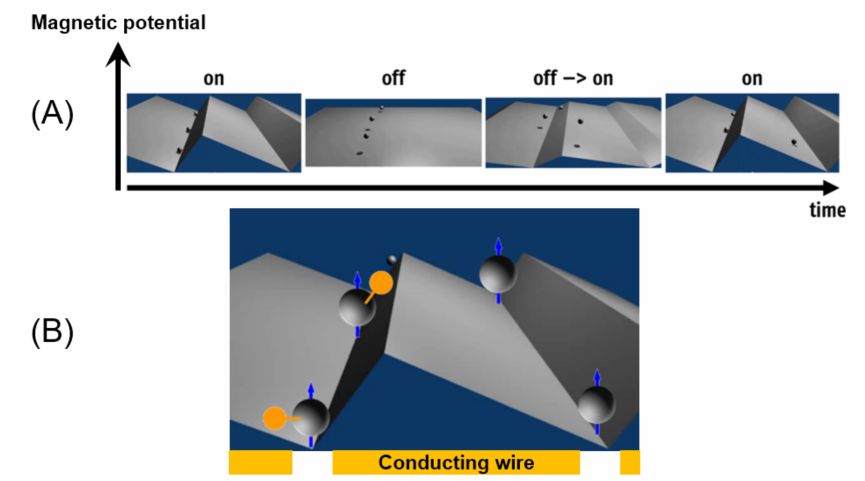
Figure 4. ( A ) Sketch of the ratchet dynamic over time. ( B ) Schematics of a magnetic on–o ff ratchet in the on-state with magnetic carriers (gray) with and without associated biomolecules